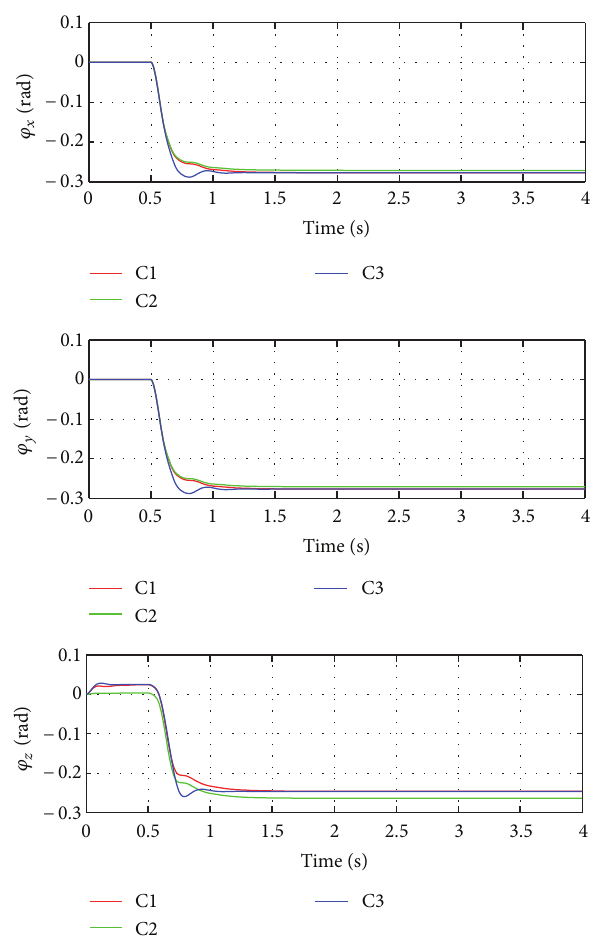
Figure 8: Response to step input: task space